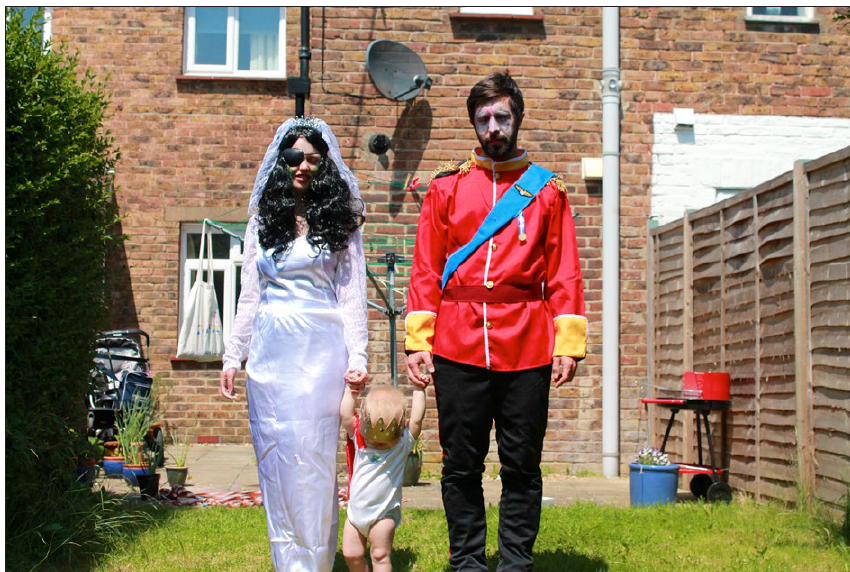
Figure 15: Jodie Hawkes, Family Portrait, digital photograph,